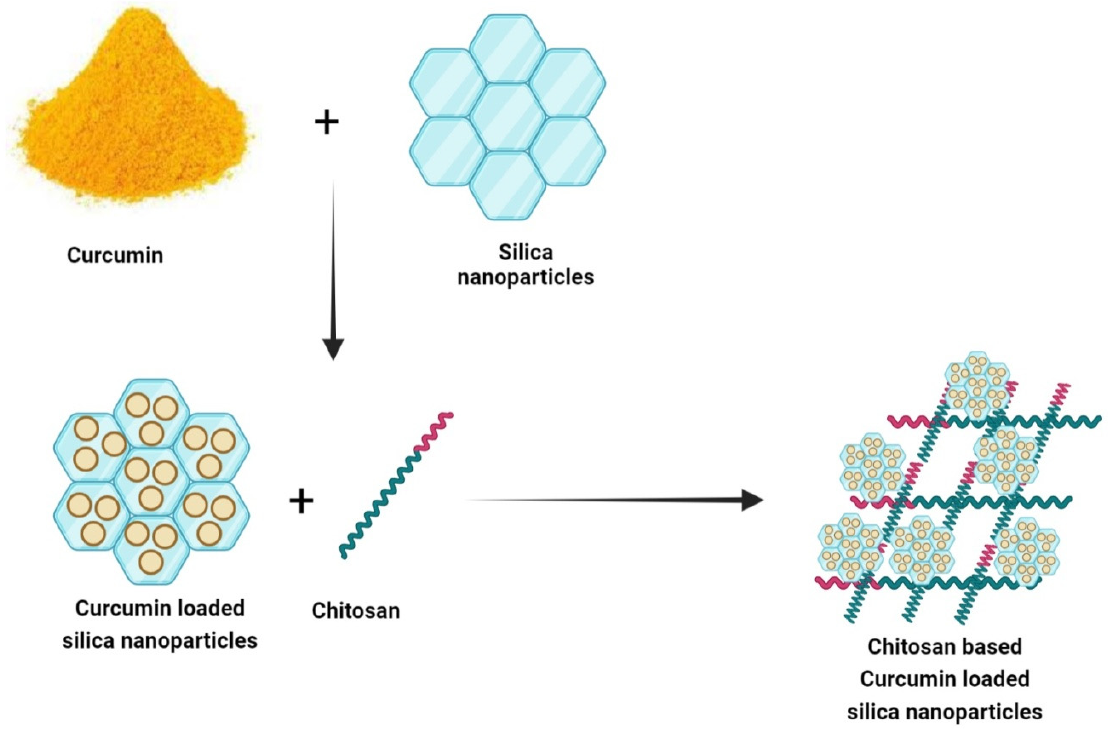
Figure 4. Preparation of CS/SBA-15/Cur bio-nanocomposite film.